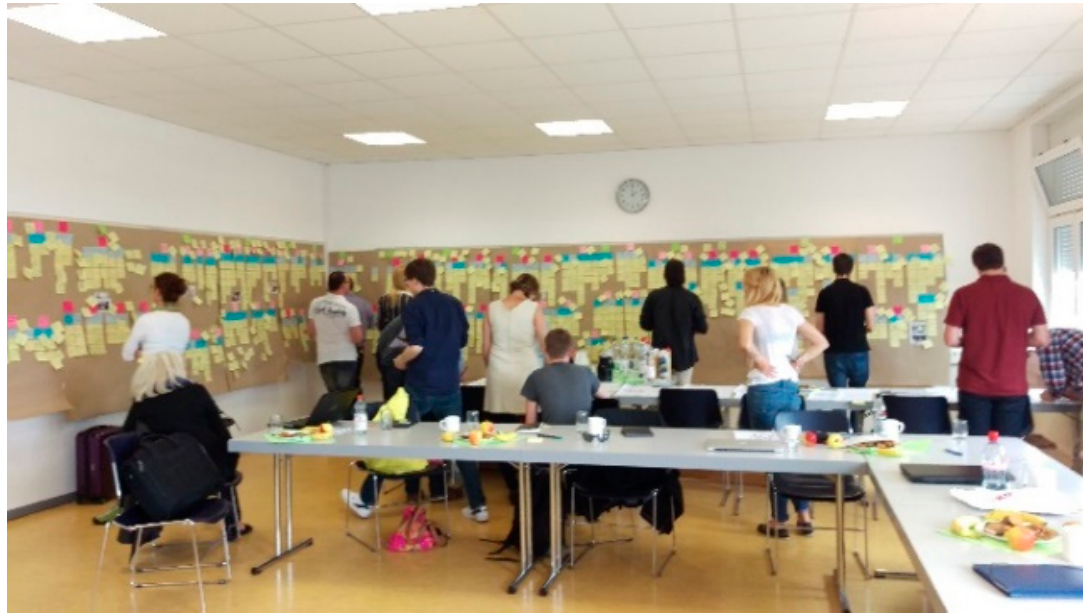
Figure 2. Interpretation session after contextual inquiry.